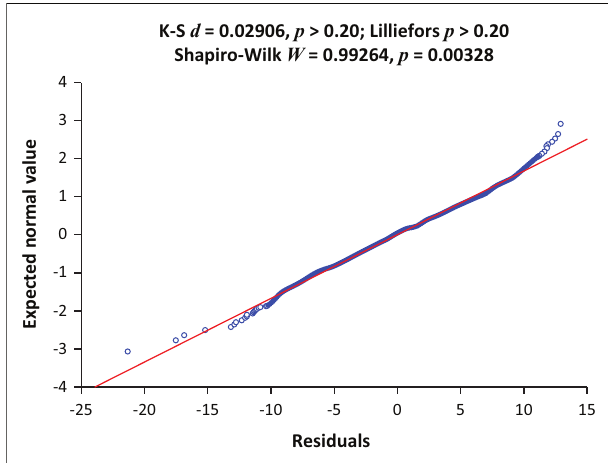
FIGURE 4: Normal probability plot of the